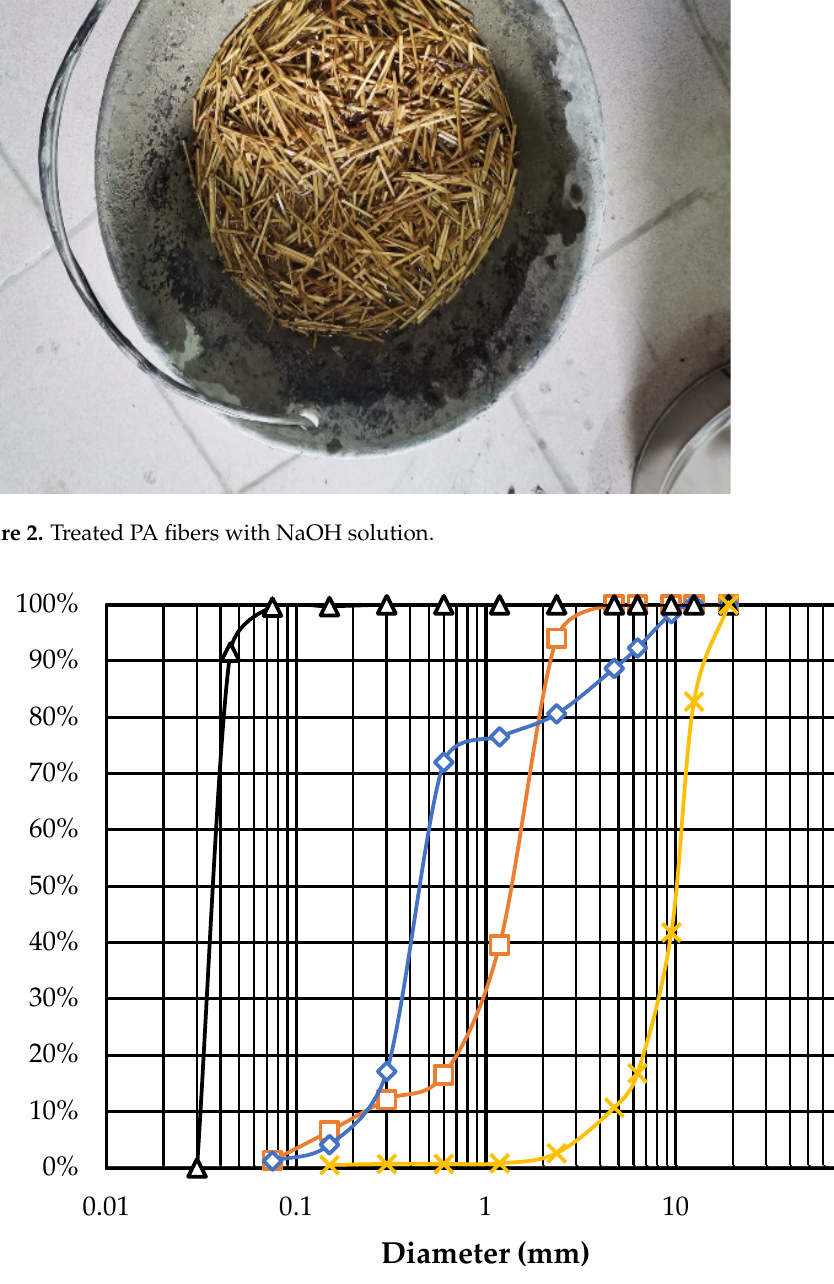
Figure 3. Particle size distribution for cement, sand, and waste glass. Table 1. Chemical composition of cement .